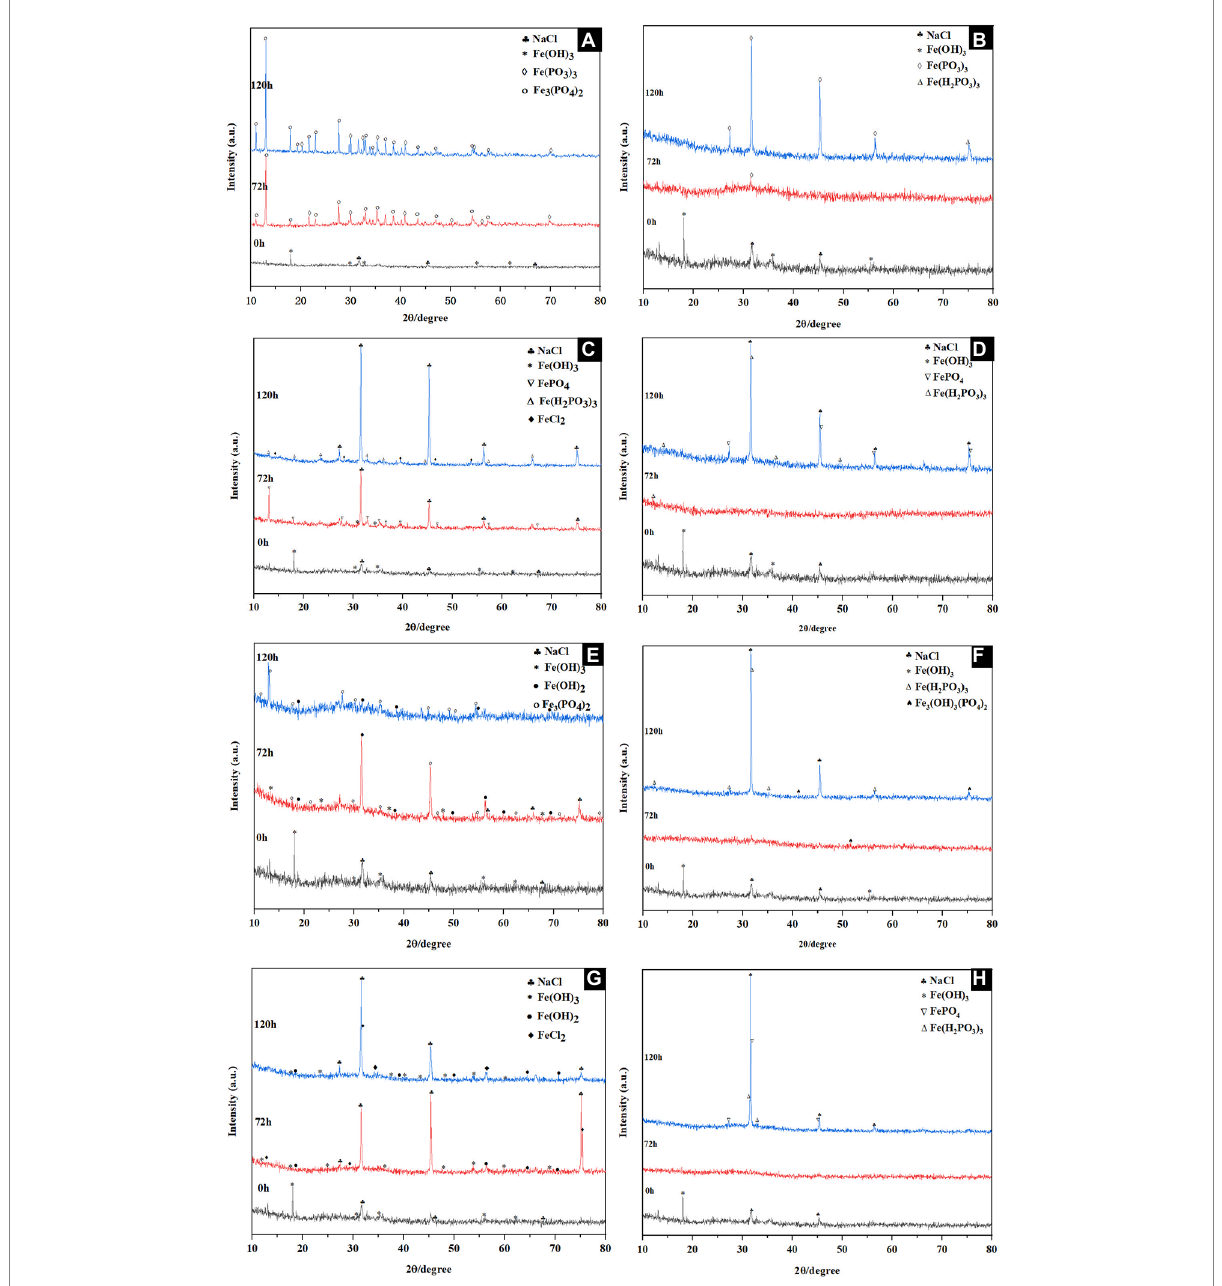
FIGURE 5 XRD patterns of substances during Fe(III) reduction with (A,C,E,G) and without (B,D,F,H) inoculation at 30 ° C in the absence of NaCl (A,B) , 30 ° C in the presence of 4% w/v NaCl (E,F) , 40 ° C in the absence of NaCl (C,D) , and 40 ° C in the presence of 3% w/v NaCl (G,H)